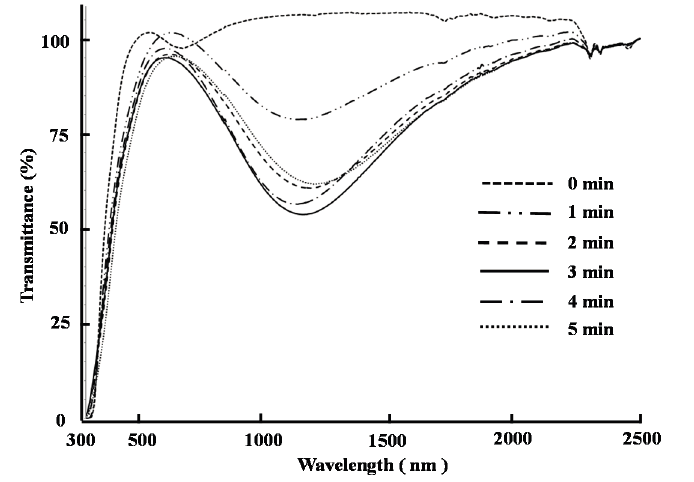
Figure 5. UV-visible-NIR transmittance spectra of films of compounds 4 and 5 with a molar ratio = 1:1 after the heating treatment at 200 °C for 0, 1, 2, 3, 4, and 5